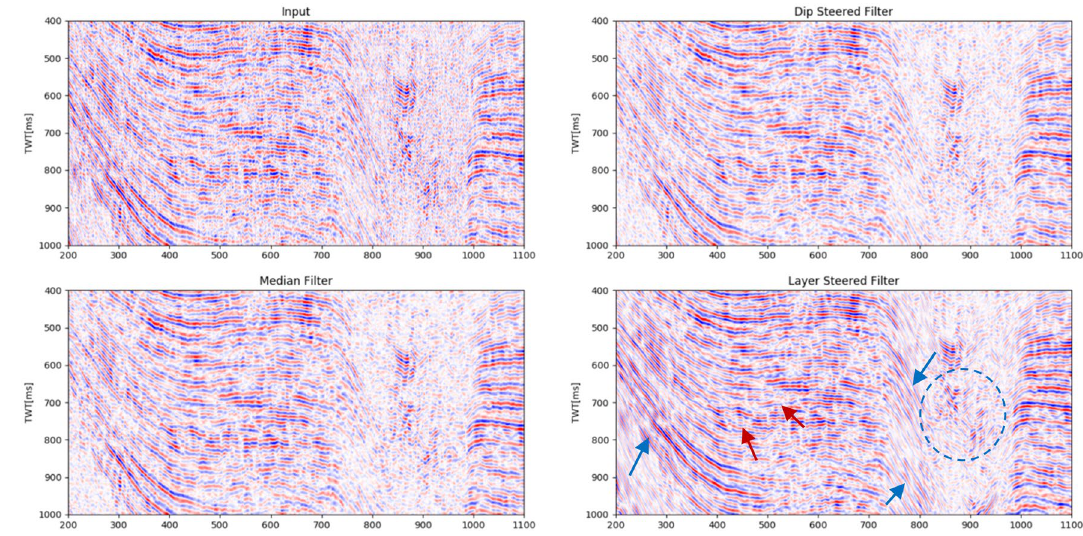
Fig. 5 Comparison of median filter, dip-steered filter, and layer-steered filter results on land seismic data. Blue arrows indicate preserved steep dip events using layer-steered filter; the blue dash circle shows details of the internal configuration of slumping sediment